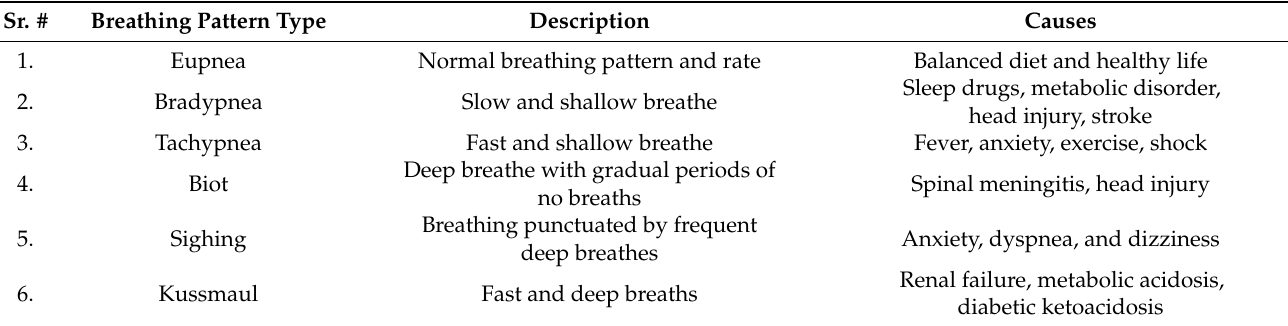
Table 1. Causes and description of different abnormal breathing